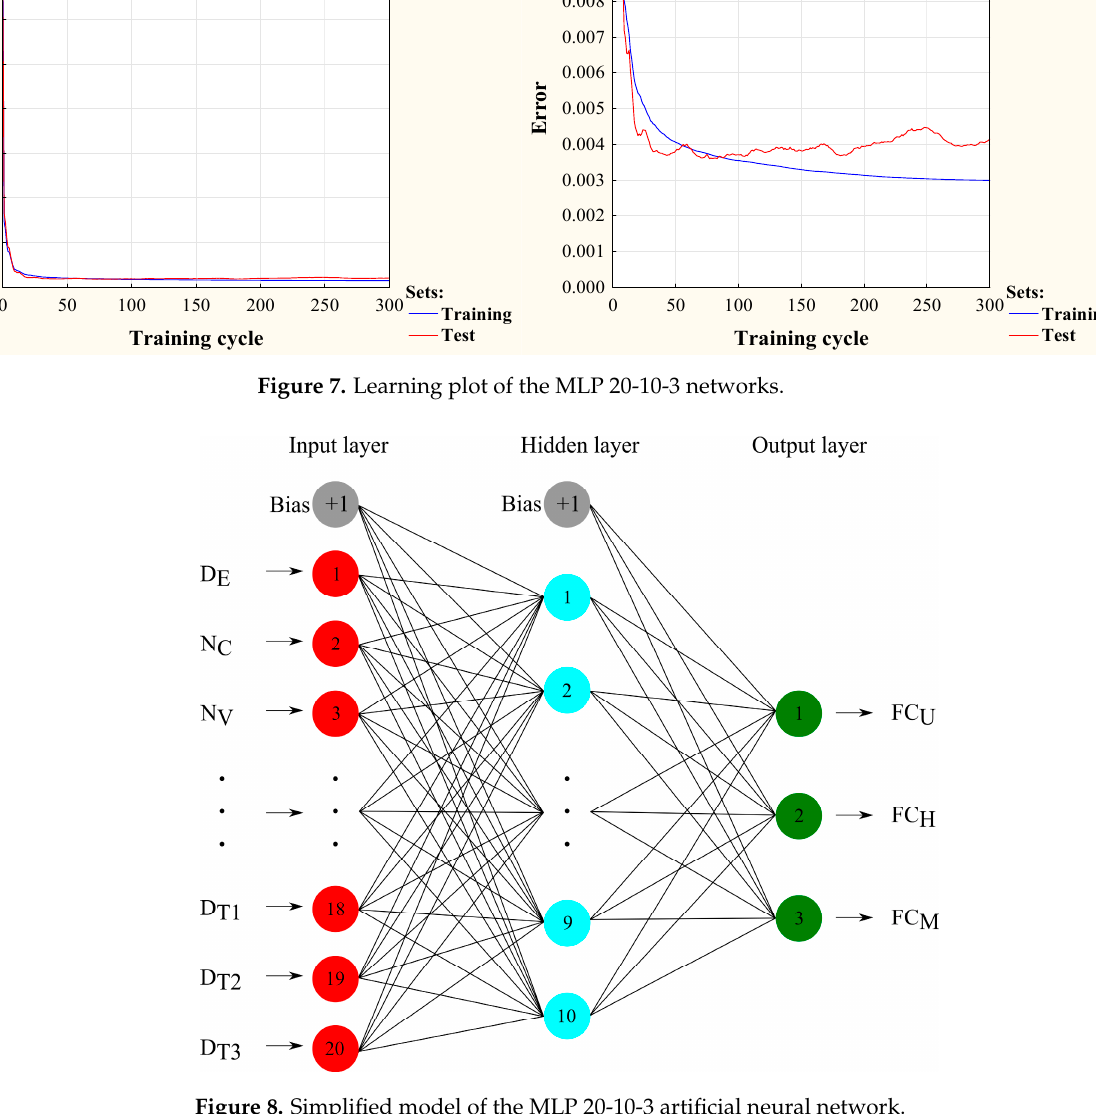
Figure 8. Simplified model of the MLP 20-10-3 artificial neural network.